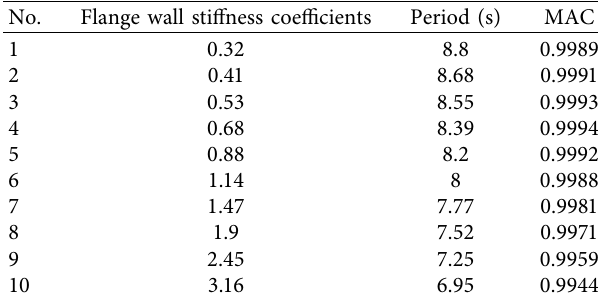
Table 4: Structural period and MAC value corresponding to the flange wall stiffness coefficients.